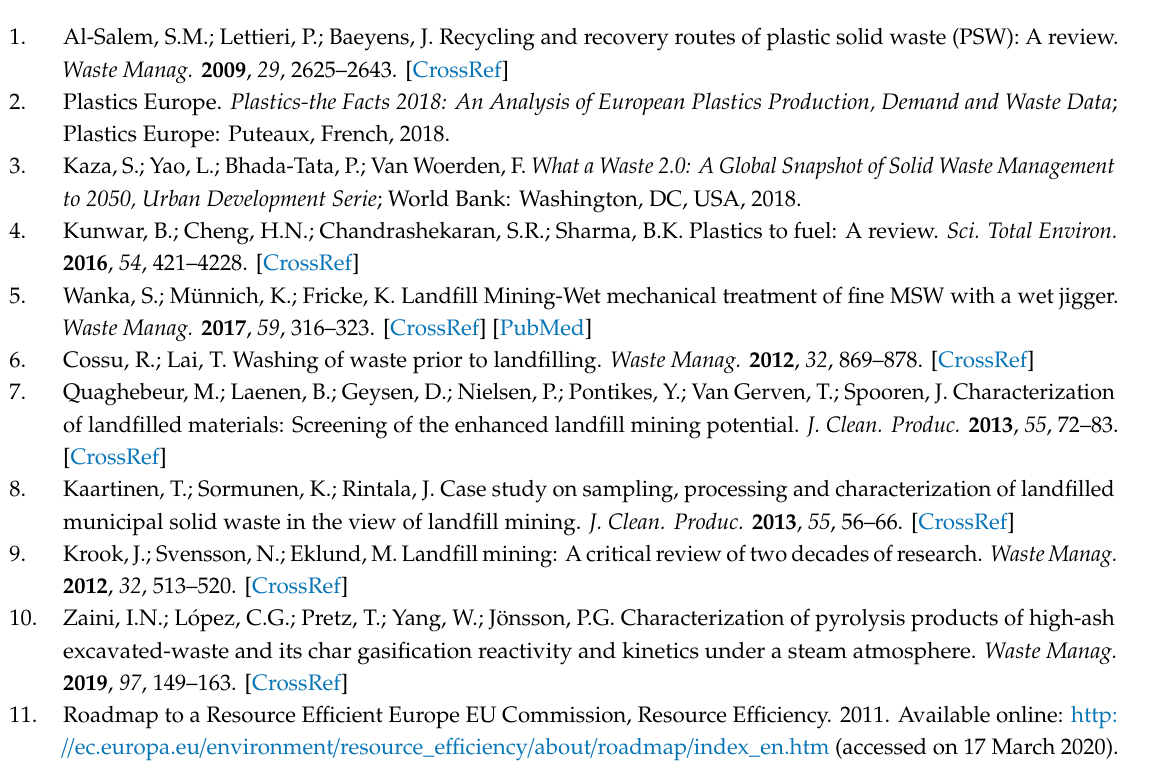
Figure S1: Pictorial Depiction of the Waste Reclamation Process Showing; (a) Allocation of Waste Landfill Ditch and Burial Pit, (b) Mining Procedure and Waste Reclamation, (c) Solid Waste Segregation After Initial Washing, (d) Shredding Machine Used and, finally, (e) Acquired Plastic Product from the Waste Shredding Process; Figure S2: Sample from the Mina Abdullah Site for the Pyrolysis Experiment (Left: as-received; Right: after densification), Figure S3: (a) TGA Curves of four Di ff erence Components Selected in the As-received Feedstock (C1: Hard Plastic; C2: Mixed Plastic Fraction; C3: Light Thin Films, C4: Tyre Rubber), (b) Averaged TGA Curves of Four Di ff erence Components Selected in the As-received Feedstock; Figure S4: Pyrolysis Liquid Collected After the Run (Left: Liquid Fraction; Right: Light Waxy Fraction), Figure S5: Pyrolysis Liquid Produced During the Run (a. At the Beginning–Start of Experimental Run; b. At the End of the Run)—Note the Heavy Fraction Liquid in the Water Condenser, Figure S6. (a) Liquid Sample Chromatogram Full Range Showing Carbon Numbers; (b) Liquid Sample Chromatogram Zoom Showing Triplet Structure for C10 to C13; (c) Liquid Sample Chromatogram Zoom Showing Carbon Numbers in The Lights Region; (d) Light Wax Sample Chromatogram Full Range Showing Carbon Numbers; (e) Heavy Wax Sample Chromatogram Full Range Showing Carbon